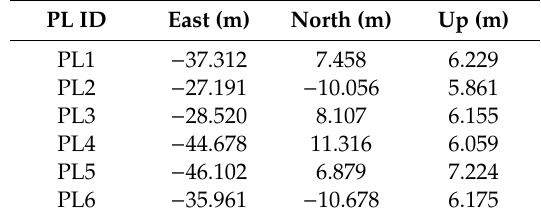
Table 6. Coordinates of six pseudolites.